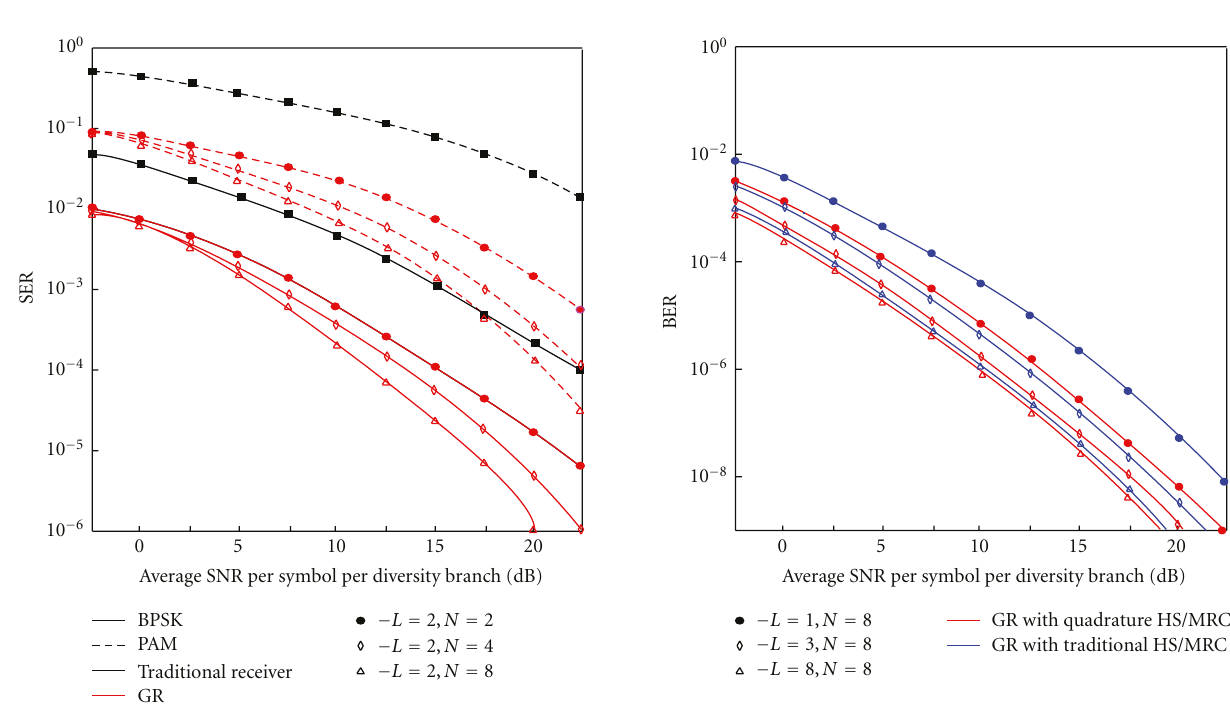
Figure 4: Average SER of coherent BPSK and 8-PAM for GR with quadrature subbranch HS/MRC and HS/MRC schemes versus the average SNR per symbol per diversity for various values of 2 N with 2 L = 4.